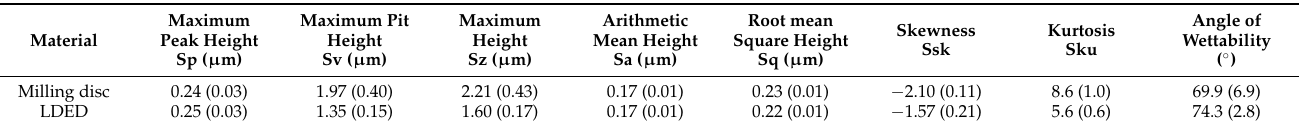
Table 3. Summary of the roughness parameters and angle of wettability obtained in the tested alloys, standard deviation (SD) in